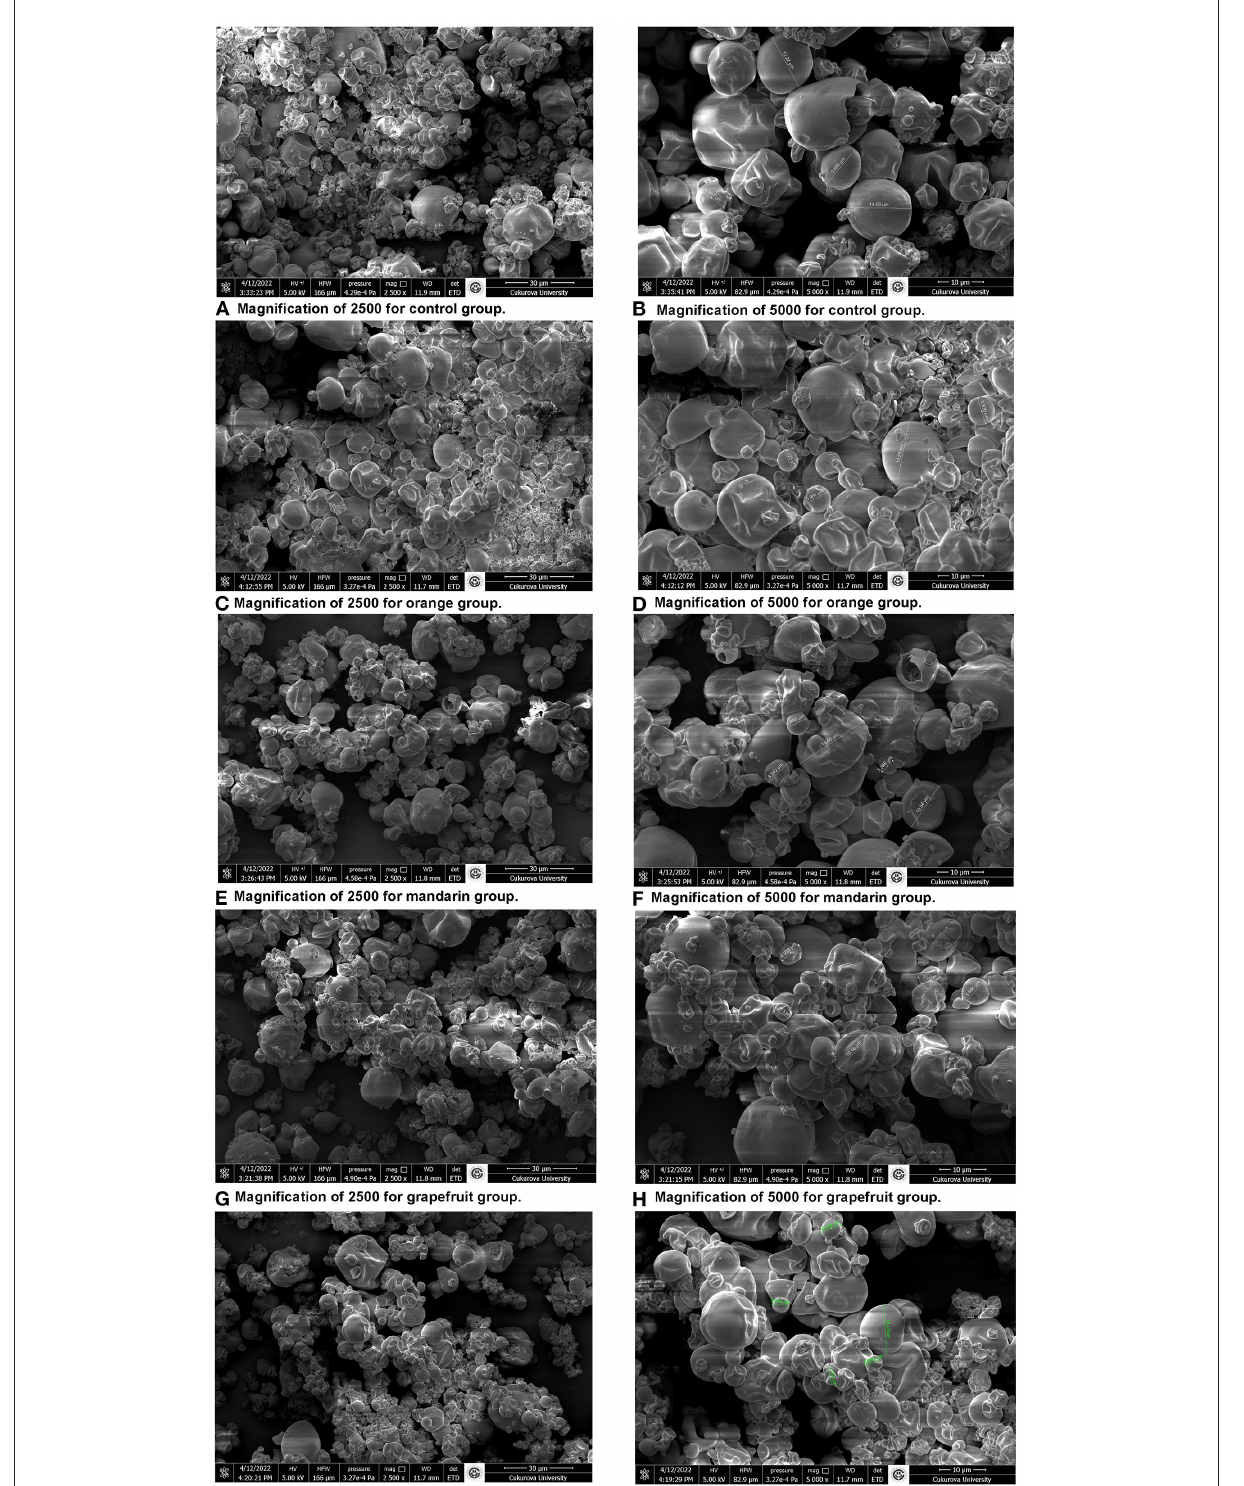
FIGURE1 Scanning electron microscopy (SEM) images of the microencapsulated fish